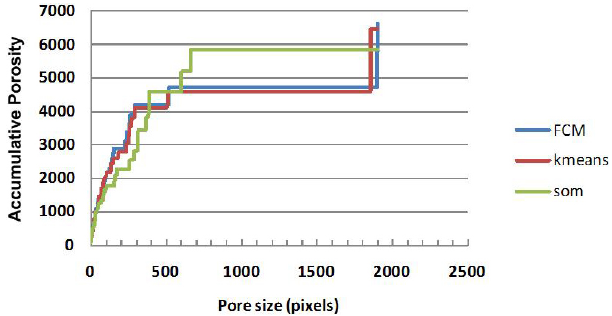
Fig. 6. Pore space distribution for the A2